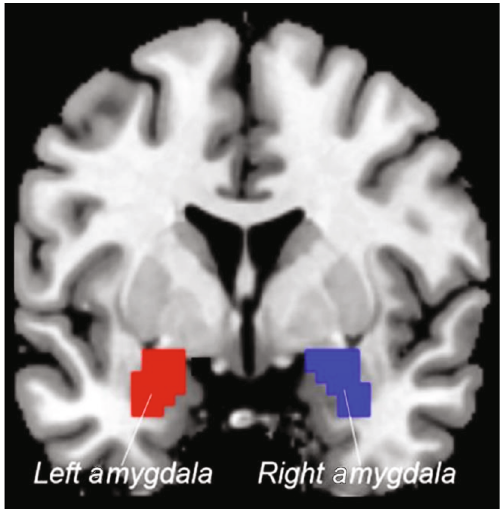
Figure 2: The left and right amygdalae were, respectively, generated based on the AAL template as seeds. Red: the left amygdala; blue: the right